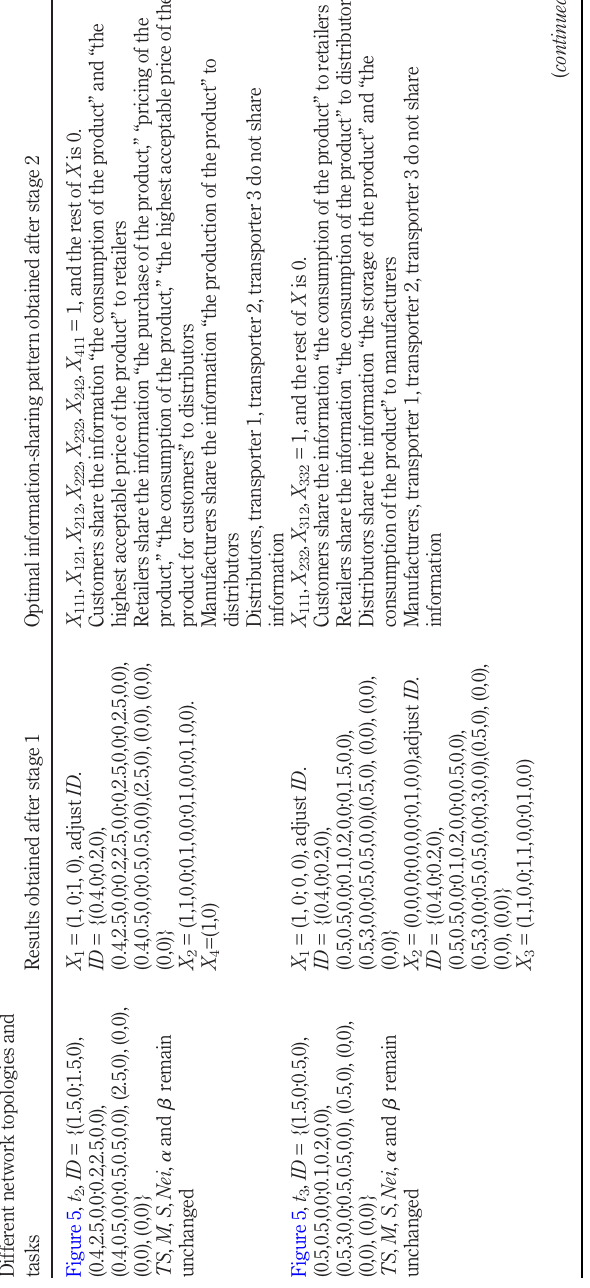
Table II. The optimal information-sharing pattern for different network topologies and tasks in supply